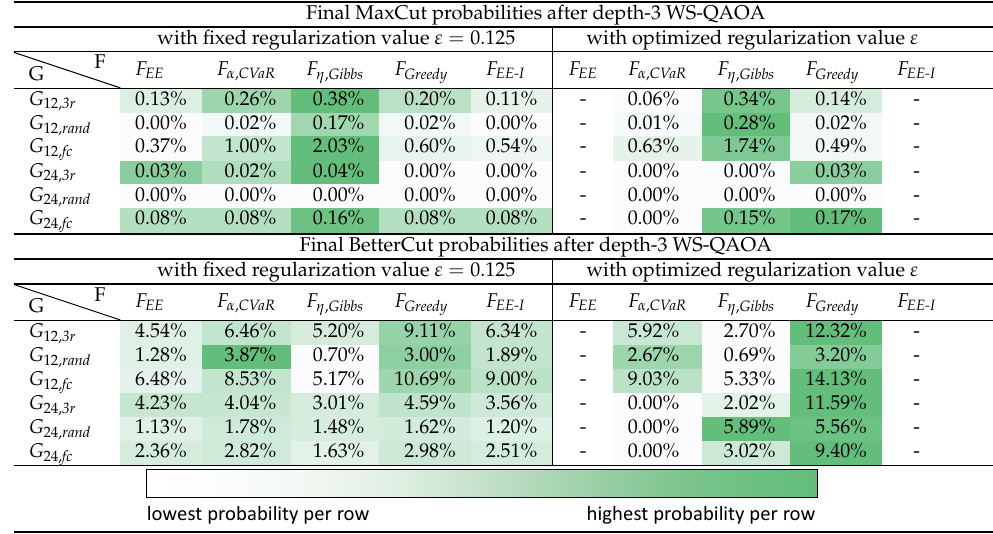
Table 2. ( Left ): Final MaxCut and BetterCut probabilities after depth-3 WS-QAOA with fixed regularization value ε . Problem instances consisting of each graph G in Figure 3 and each objective function F (Equations (3)–(7)) were used. α was fixed at 0.05. η was set to 5 for the 12-node graphs and 2 for the 24-node graphs. The smaller η accounts for larger achievable cut sizes in the 24-node graphs; however, the values are, in essence, arbitrary (see [34]). Initial cuts are given in Table 1, for G 12, fc the initial cut was 111010111010 (cut size: 91). Values reflect median probabilities observed in 20 runs per configuration. ( Right ): Final probabilities after depth-3 WS-QAOA when ε is determined by the optimizer during the depth-1 round of incremental partial optimization. The same problem instances as above and the objective functions F α , CVaR , F η , Gibbs , and F Greedy are considered. Highest values in each row are